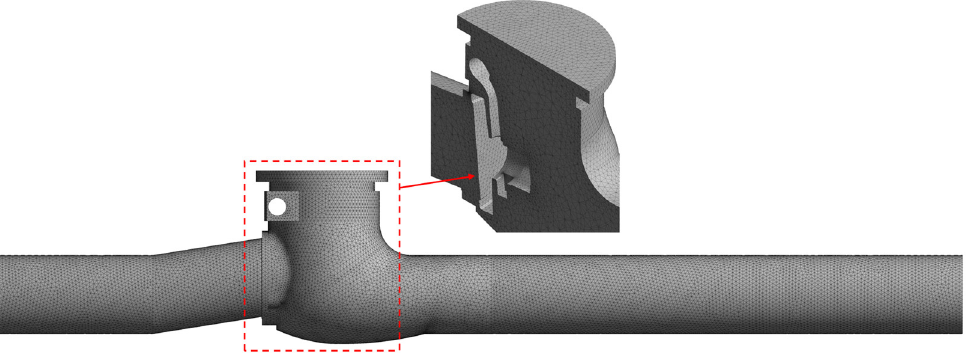
Figure 4. Computational domain and meshing of the swing check